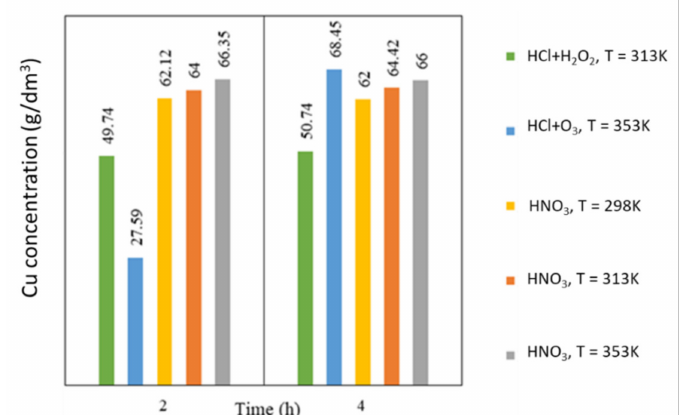
Figure 3. Copper concentration obtained after leaching in most efficient agents—HNO 3 and HCl with the addition of H 2 O 2 or O 3 during 2 h and 4 h.